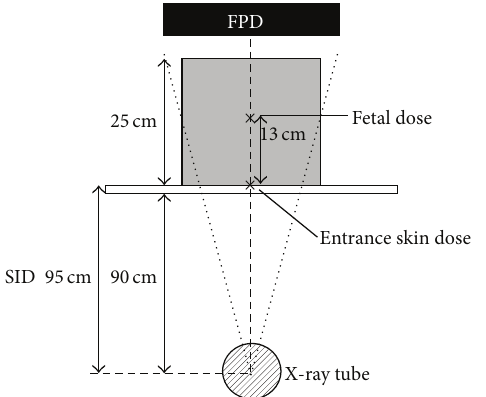
Figure 2: The X-ray tube-image intensifier C-arm in relation to the phantom used to simulate the fetal radiation dose in the operating suite. I.I., image